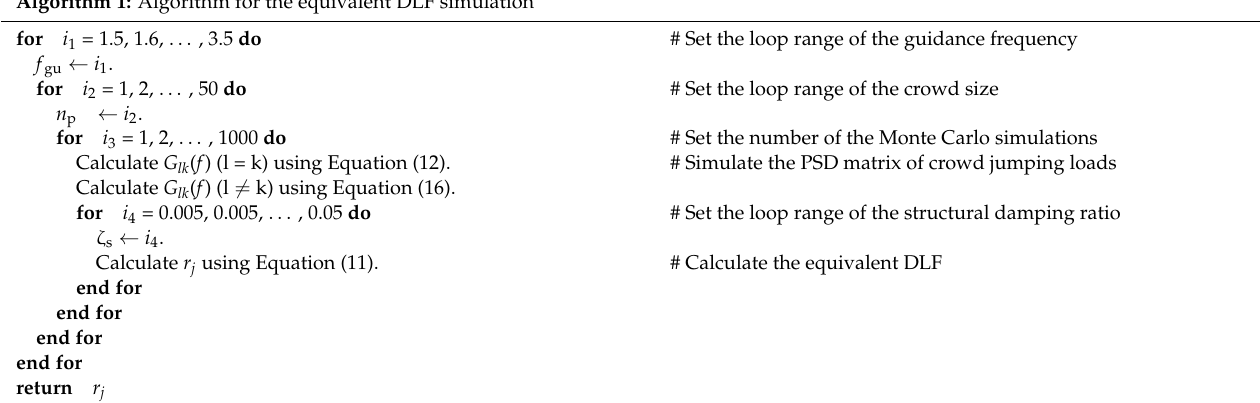
Algorithm 1: Algorithm for the equivalent DLF